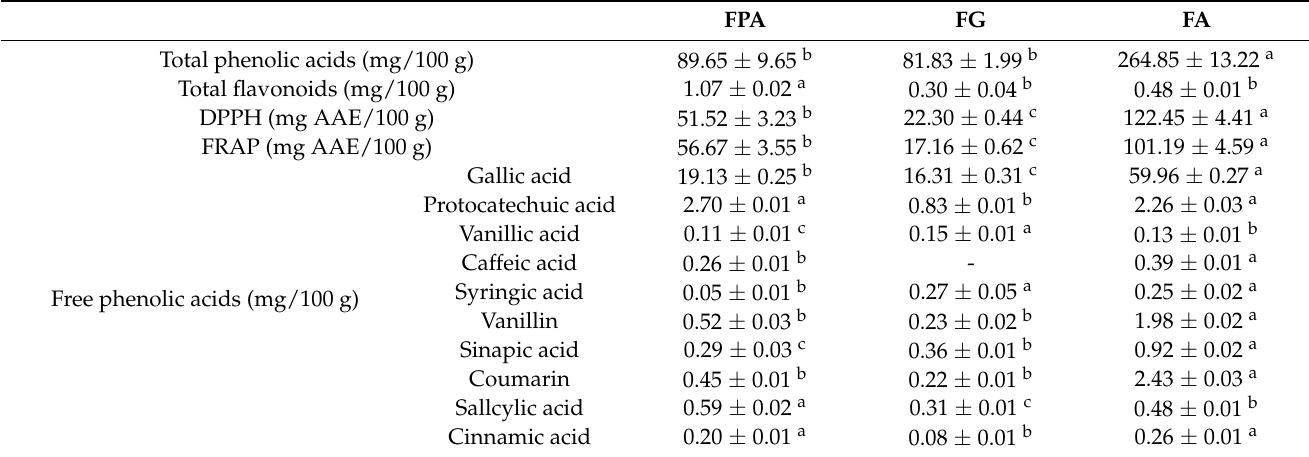
Table 2. The phenolic acid profiles and antioxidant activities of FPI, FG, and FA. FPA FG FA Total phenolic acids (mg/100 g) 89.65 ± 9.65 b Total flavonoids (mg/100